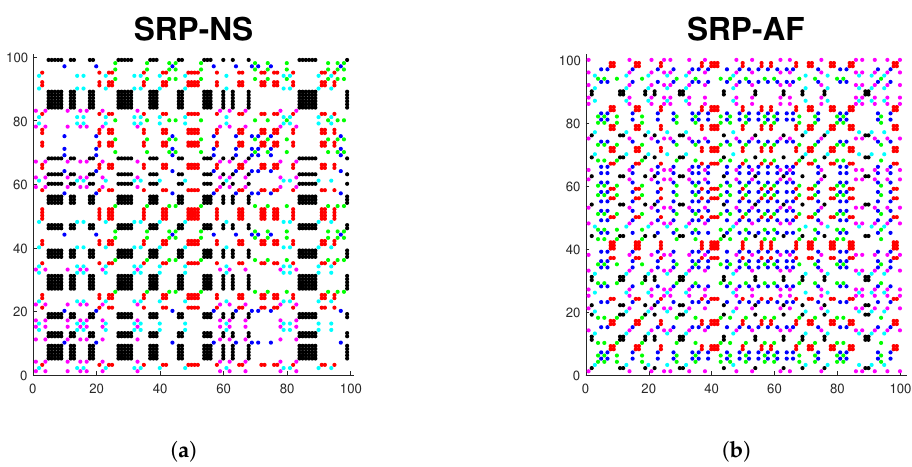
Figure 1. SRPs of a 102-length RR interval time series for an embedding dimension m = 3 in a normal sinus ( a ) and atrial fibrillation ( b )